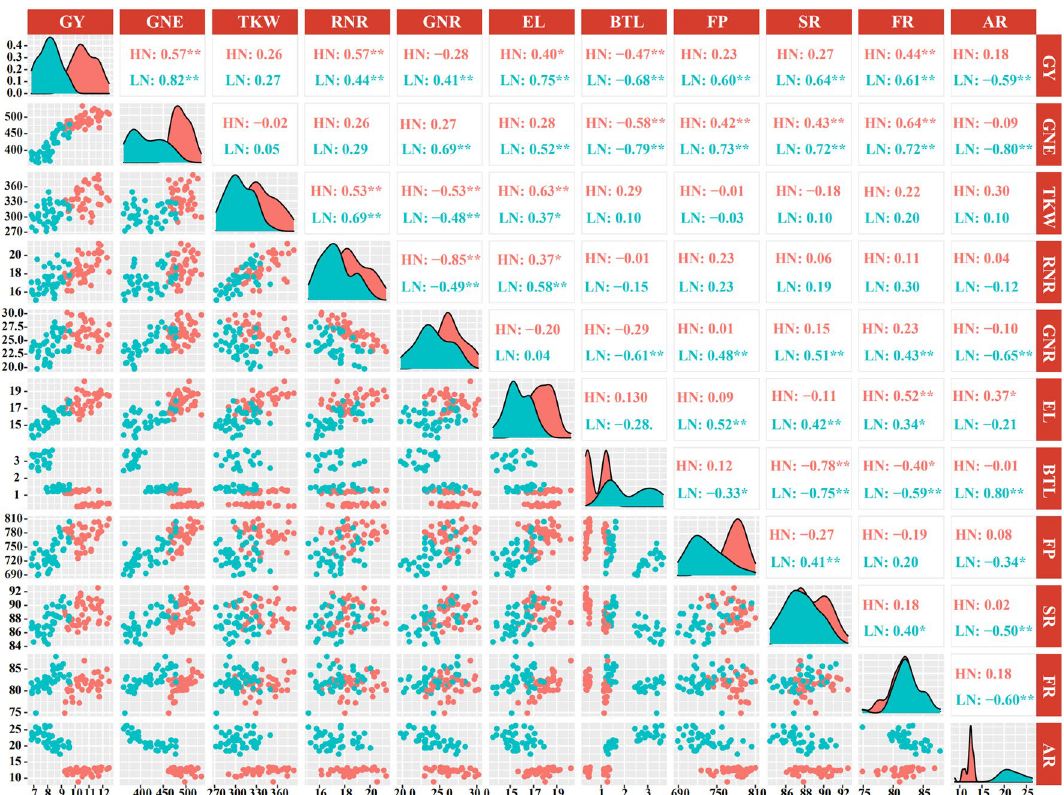
Figure 2. The relationship between Grain yield and its components and ear differentiation traits under both N conditions. The * and **indicate that at the level of 0.05 and 0.01, respectively. GN grain yield, GNE grain